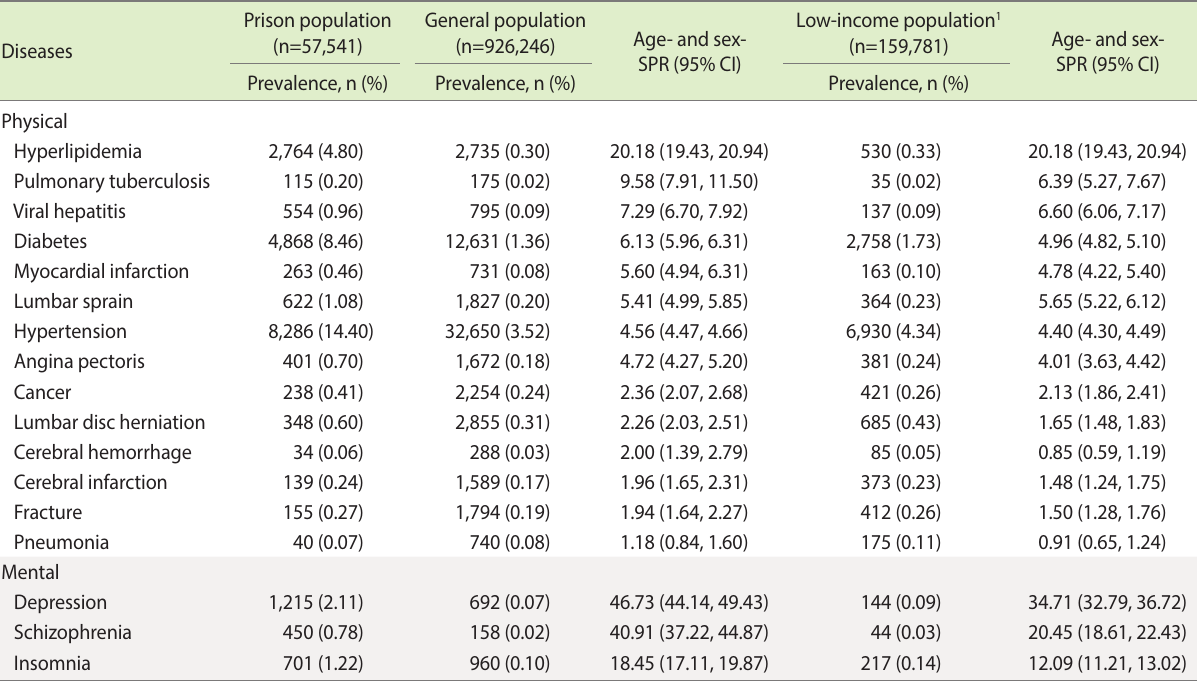
Table 2. SPRs of health outcomes between the prison population and the general population in Korea